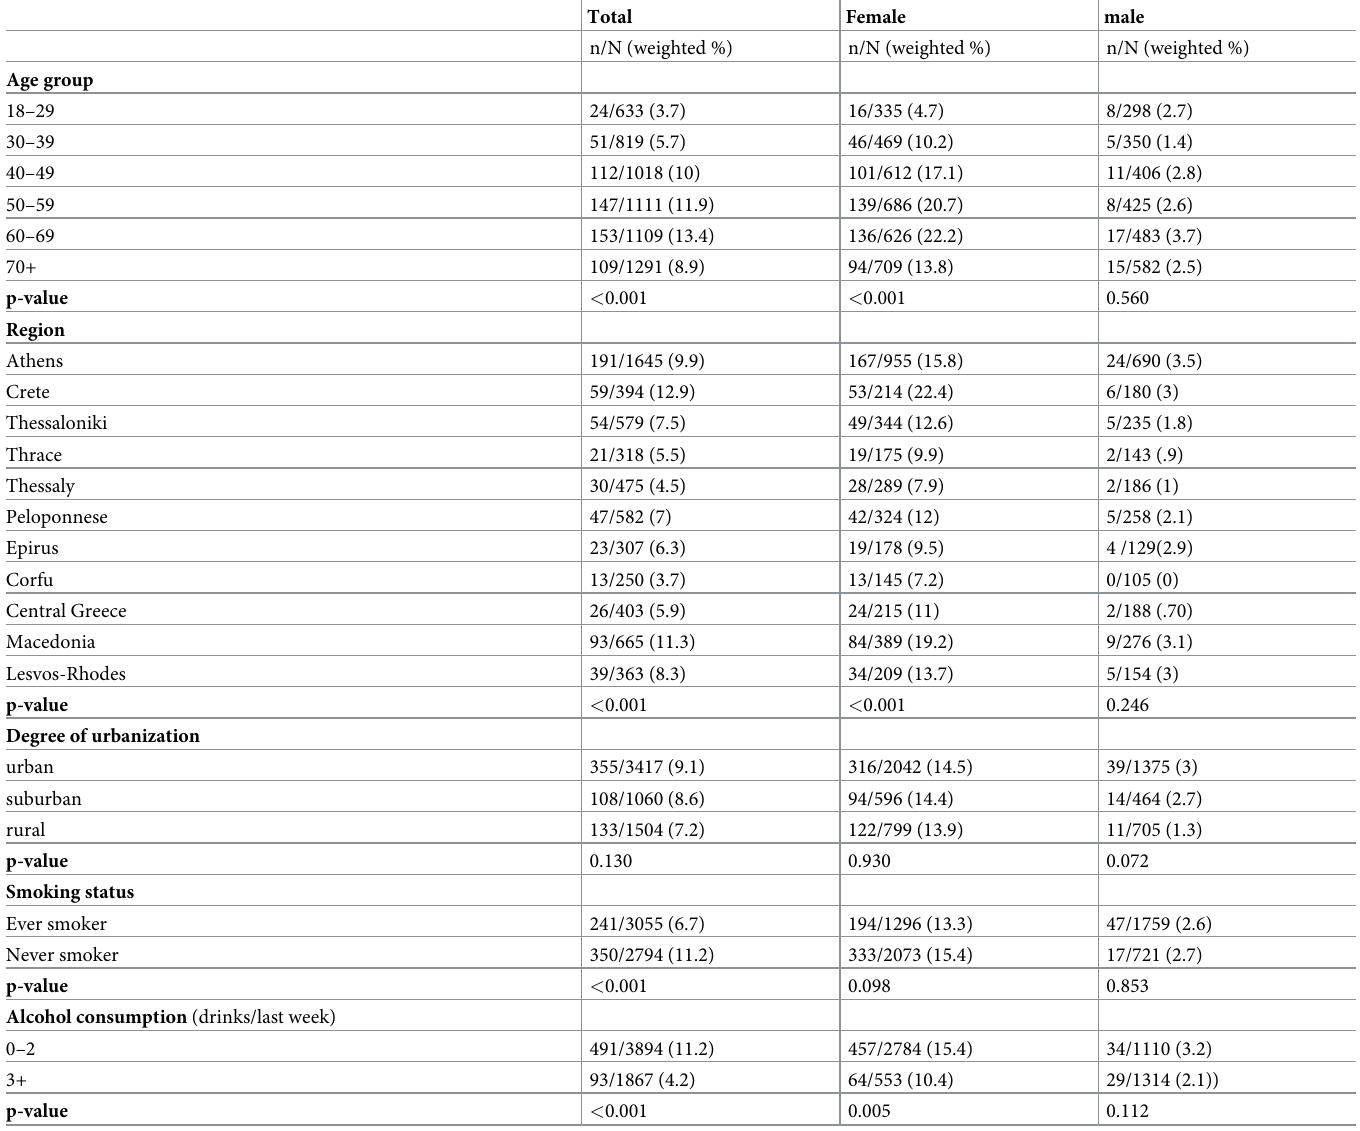
Table 2. Prevalence of hypothyroidism (overall and by